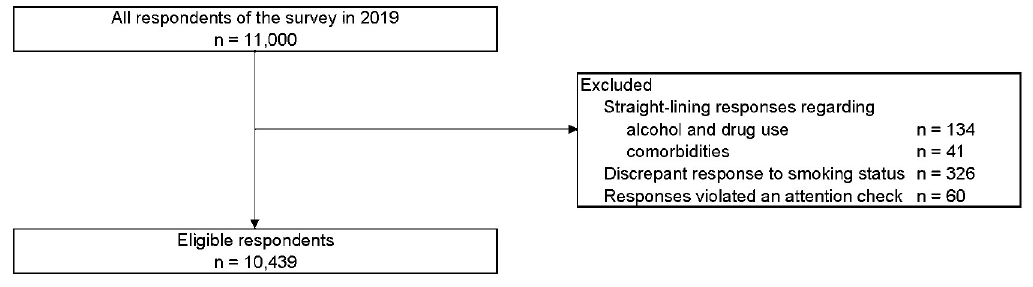
Fig 1. Flow diagram of the